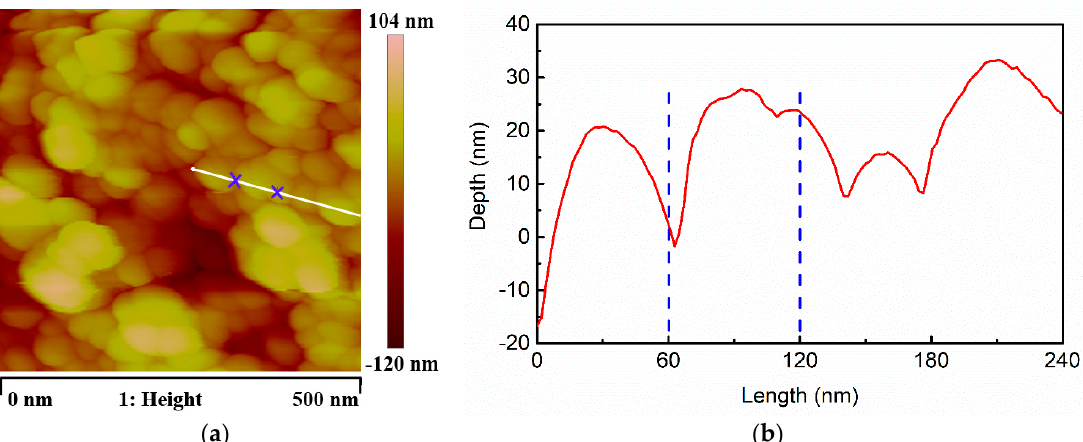
Figure 5. AFM image of TiO 2 based aqueous super-hydrophobic suspension coated on a silicon wafer: ( a ) Top view; ( b ) Sectional height difference along the white line in ( a ).